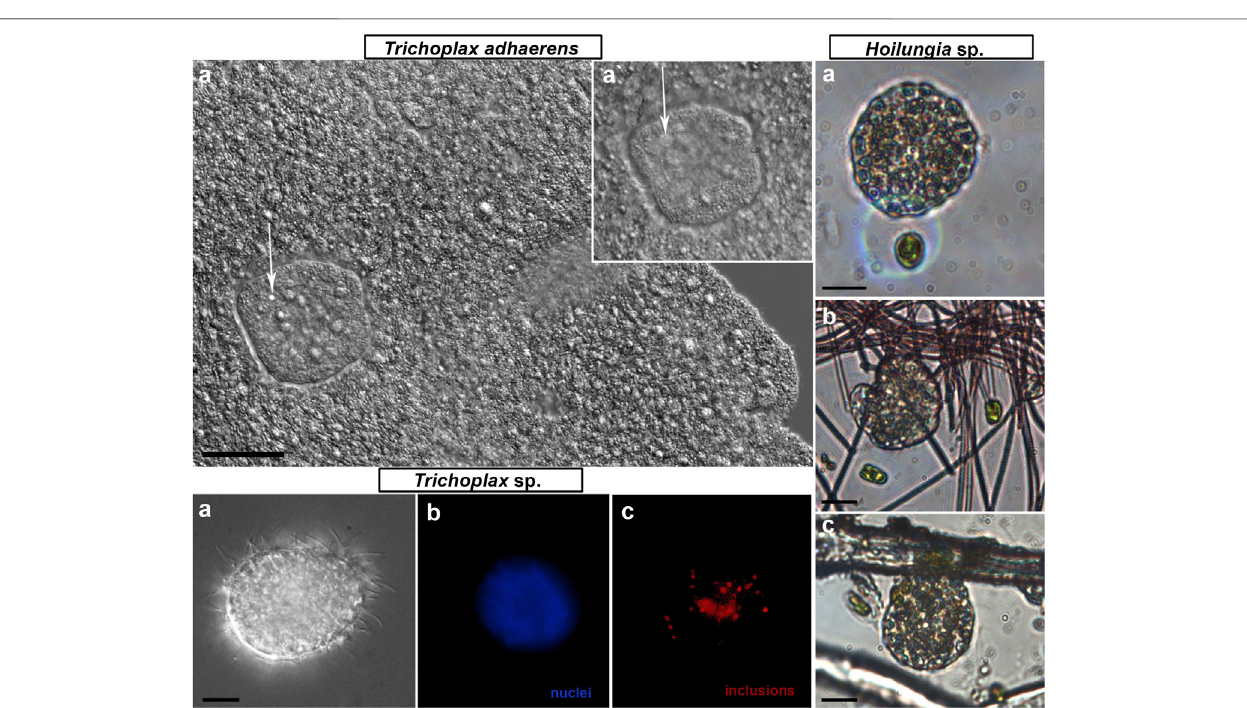
FIGURE 5 | “ Swarmers ” were formed in the long-term culture in every studied species of Placozoa. “ Swarmers ” are small (15 – 30 µm diameter) juvenile animals (white arrowsin T.adhaerens box, (A – A 9 ) — differentZ-layer). “ Swarmers ” expressedcoordinatedexploratoryandfeedingbehaviors( Hoilungia sp.box,H4haplotype,threeillustrative images of different juvenile animals). Trichoplax sp. box: (a) — DIC view of the solid swarmer-like animal; (b) — high density of nuclei in the center; (c) — auto fl uorescence. Scale bar: 10 µm.